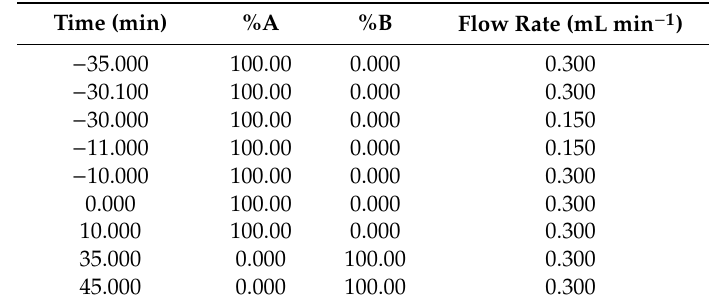
Table 1. Solvent gradient elution program used for the elution of sugars. Negative values represent equilibration